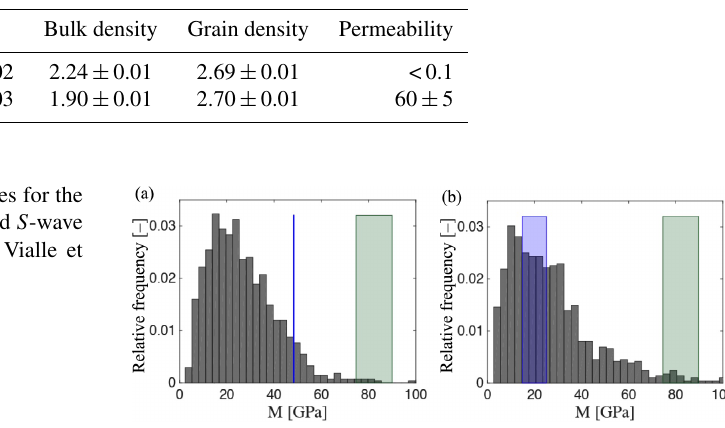
Figure 1. Nanoindentation results for Carb-A (left-hand side) and Carb-B (right-hand side). In blue we illustrate the corresponding moduli range from ultrasonic experiments on dry samples from 0 to 30 MPa confining pressure, and in green we illustrate the mod- uli range given by the solid anisotropic calcite crystal. Overall we observe that the medium effective indentation module M is slightly stiffer for Carb-A (26GPa vs. 25GPa).